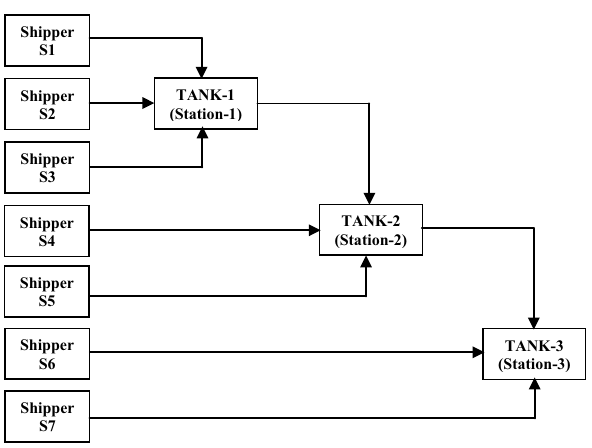
Fig. 2 Block diagram of oil distribution and mixing phenomena in Krisna field